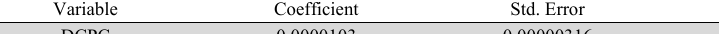
Regression of DING and